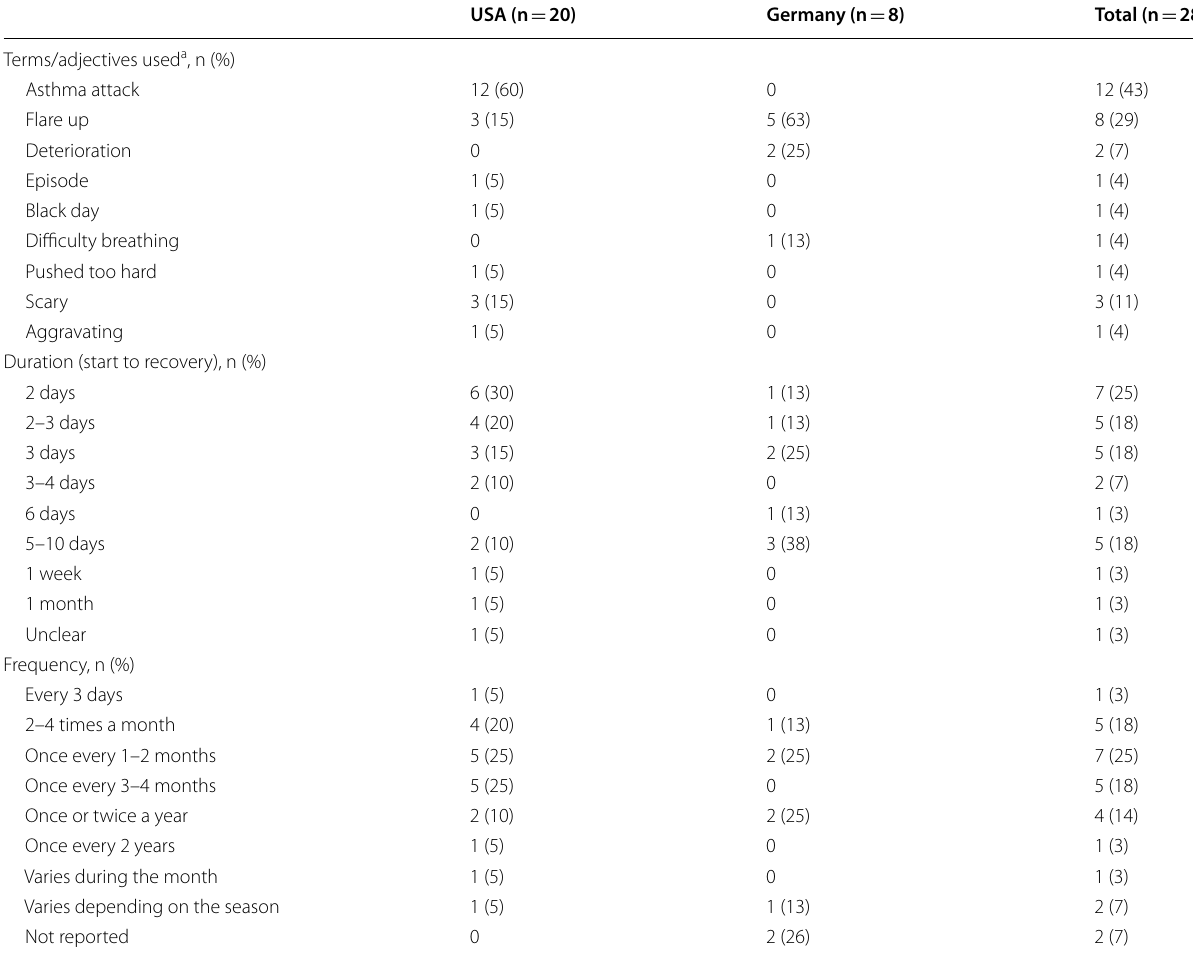
Table 2 Patient description of moderate asthma